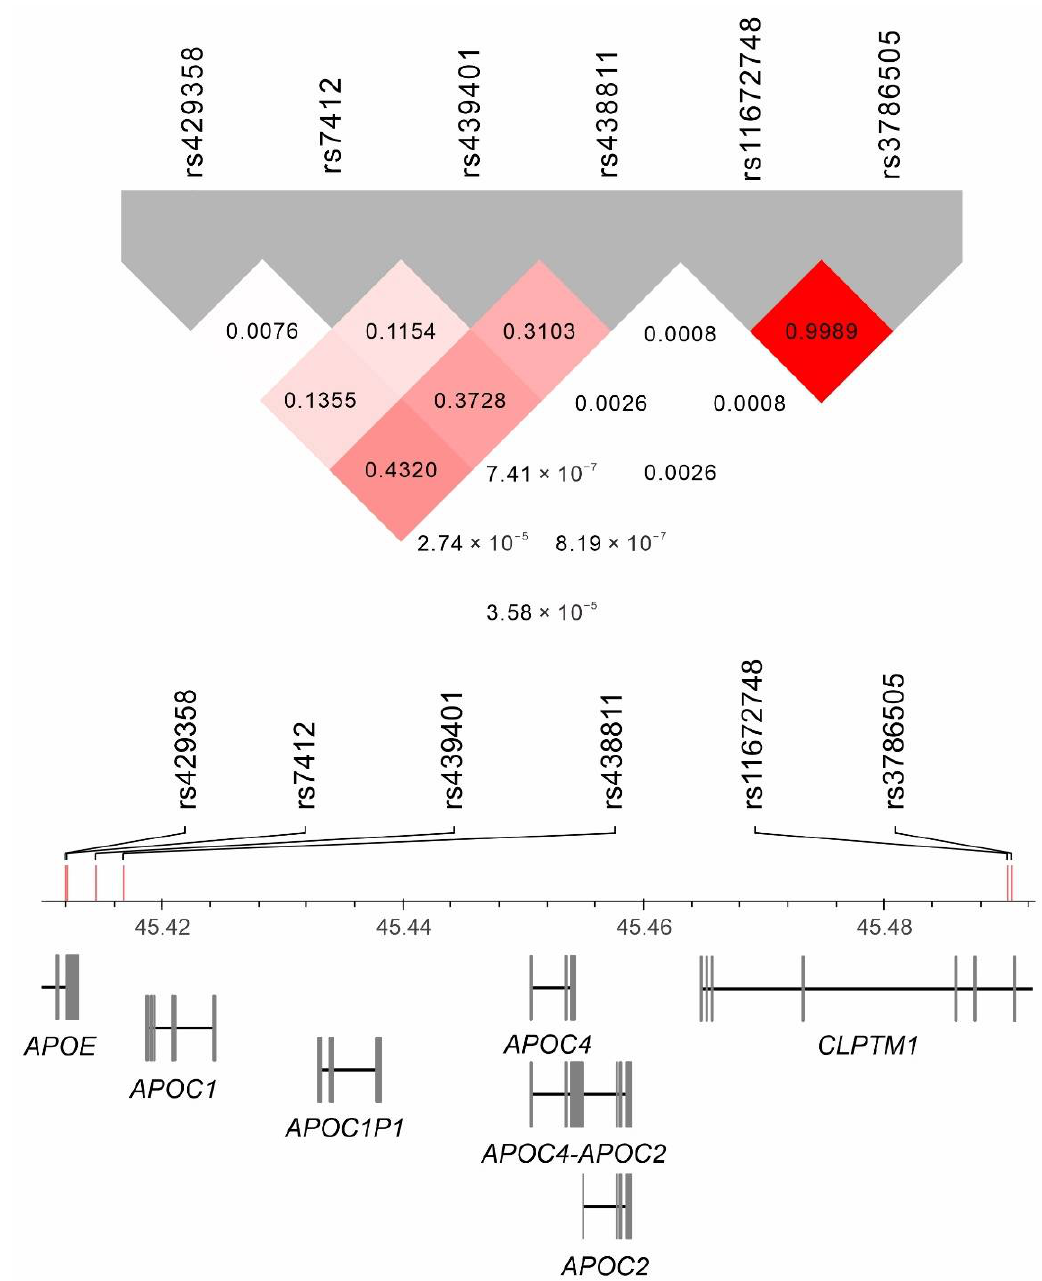
Figure 3. Linkage disequilibrium of APOE gene region lead single-nucleotide variants.